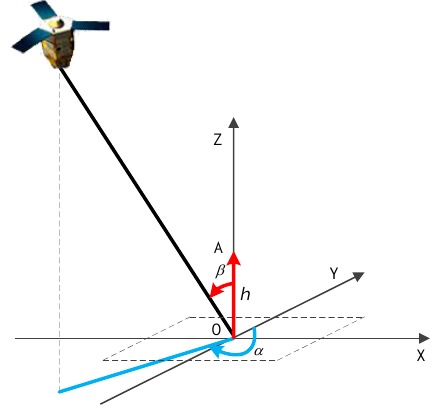
Figure 1. Imaging scene of an inclined satellite